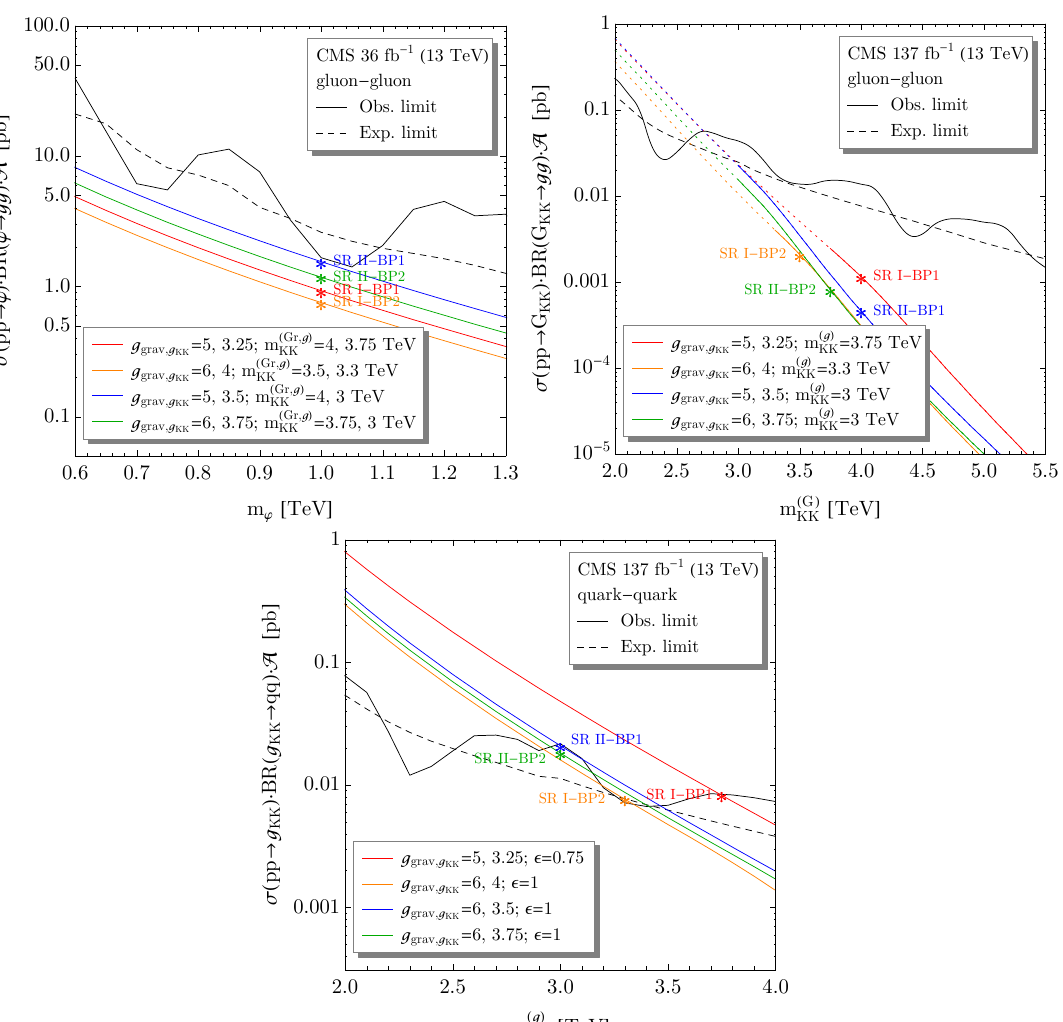
Figure 5 . Top-left: gg -produced low-mass ( . 1 . 5 TeV) resonance bounds from the CMS dijet √ search with an integrated luminosity of 36 fb − 1 at s = 13 TeV [40]. The color-coded lines are the fiducial cross-sections of radion production for four sets of parameter choices on which our benchmark points in table 1 are marked by asterisk symbols. The BR of radion to two SM gluons is (almost) 100%, while an acceptance of 100% is applied for conservative estimates. Top-right: gg - produced high-mass ( & 1 . 5 TeV) resonance bounds from the CMS dijet search with an integrated √ luminosity of 137 fb − 1 at s = 13 TeV [29]. The color-coded lines are the fiducial cross-sections of KK graviton production with m ϕ set to be 1 TeV for four sets of parameter choices on which our benchmark points are marked by asterisk symbols. The segments drawn by dotted lines are for the situation of m ( G ) < m ( g ) that is theoretically disfavored. Bottom: qq -produced high-mass KK KK ( & 1 . 5 TeV) resonance bounds from the CMS dijet search with an integrated luminosity of 137 fb − 1 √ at s = 13 TeV [29]. The color-coded lines are the fiducial cross-sections of KK gluon production for four sets of parameter choices with m ϕ = 1 TeV on which our benchmark points are marked by asterisk